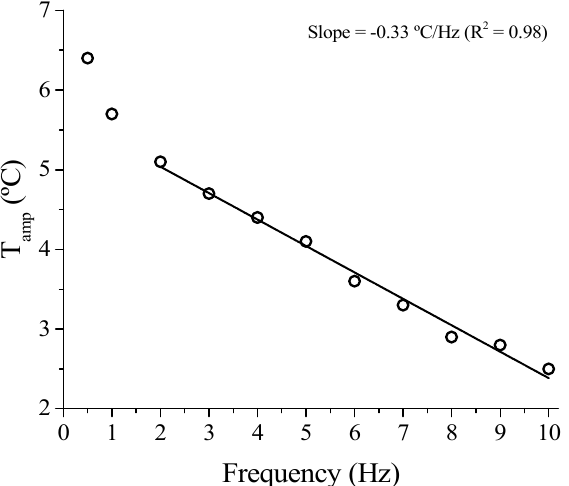
Figure 11. Temperature amplitude ( T amp ) of the NiTi Belleville spring as a function of loading frequency.